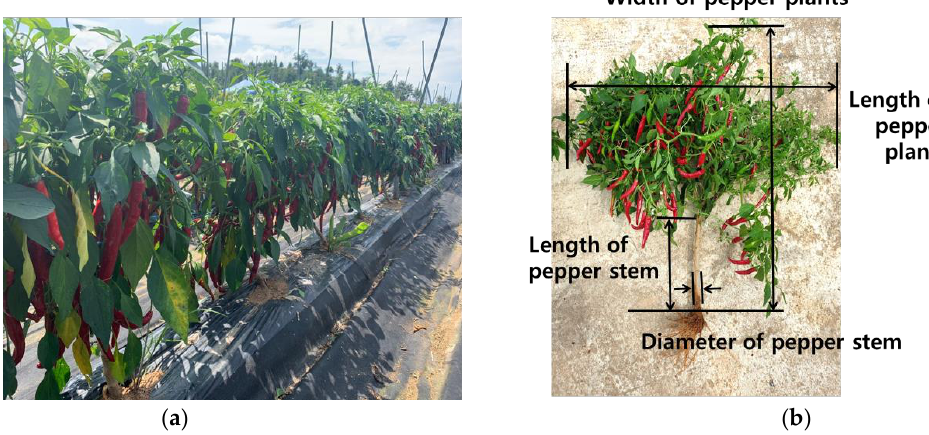
Figure 4. Pictures of the ( a ) pepper plants and ( b ) physical properties of pepper used in this study. Table 2. Average (AVE) and standard deviations (SD) of the physical properties for peppers.